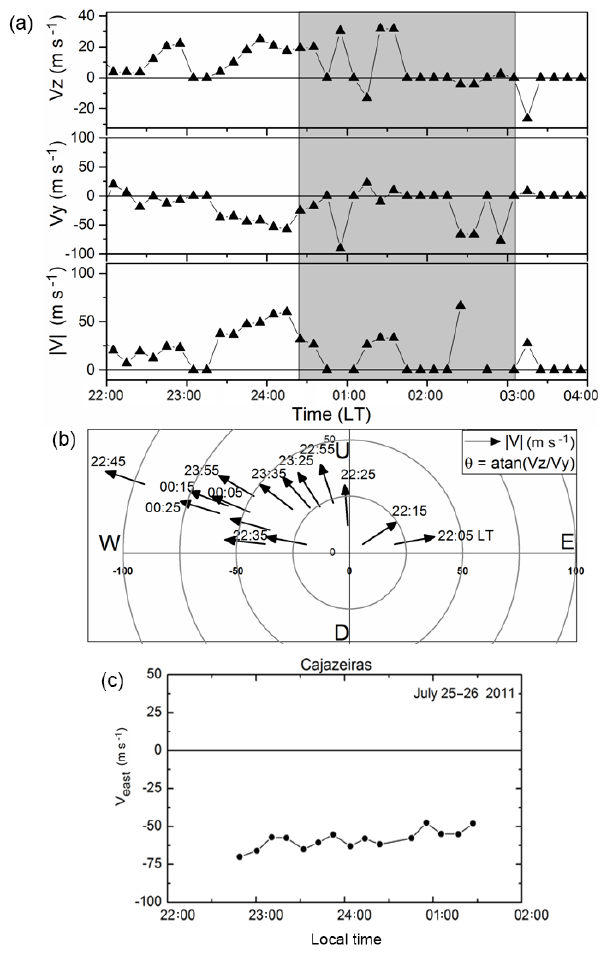
Figure 6. (a) Vertical ( V z ), zonal ( V y ), and total ( | V | ) drift veloci- ties on 25–26 July 2011 over FZ from 22:00 to 04:00LT. V y > 0 is eastward. (b) Vector diagram showing the variations and directions of the mean total drift velocity of the irregularities seen as spread F in ionograms. For clarity, the | V | values are represented by the arrow start points. (c) Zonal drift velocities obtained from the de- pletions seen on the OI 630.0nm emission images obtained at CZ on 25–26 July 2011 for comparison.